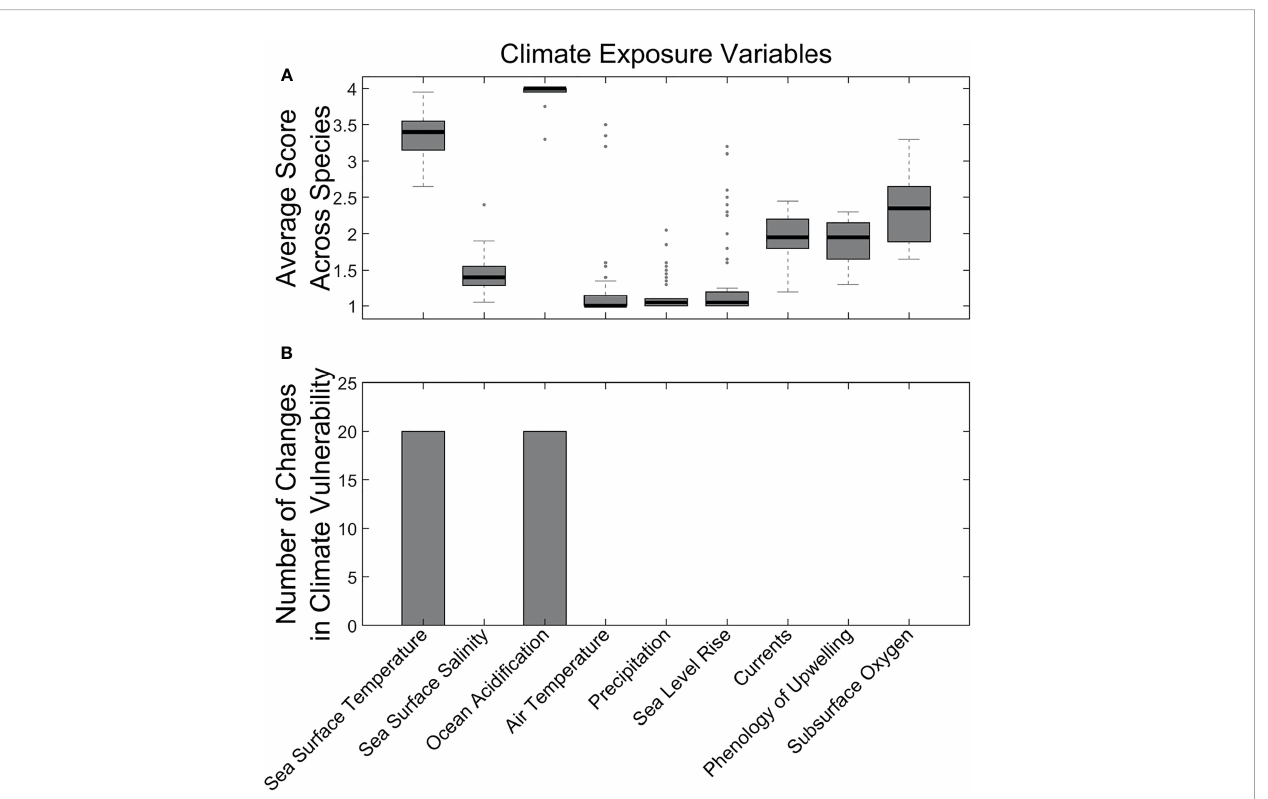
FIGURE 4 Average climate exposure scores across all species (A) and results of sensitivity analysis (i.e., removing the factor) for the effect of individual exposure factors on overall climate vulnerability (B) . Methods follow those in Morrison et al.